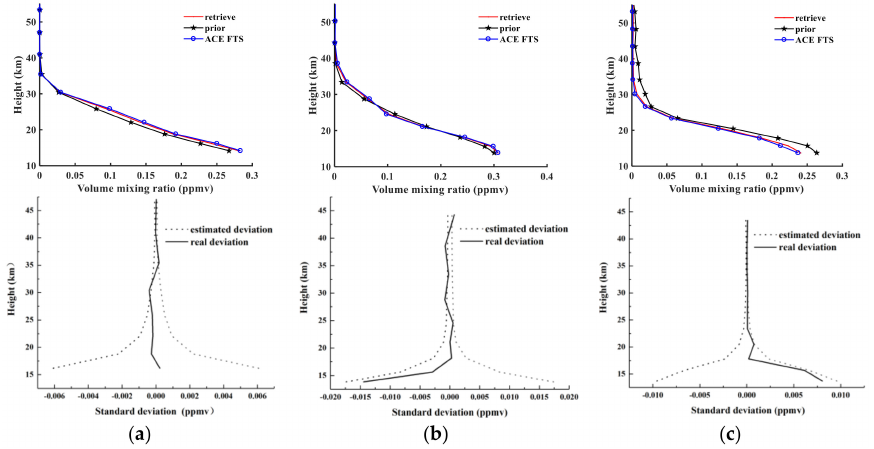
Figure 9. Top panels show N 2 O retrieval results for ( a ) sunrise orbit 40993; ( b ) sunrise orbit 40993; and ( c ) sunrise orbit 48359. Bottom panels show real and estimated absolute deviations for ( a ) sunrise orbit 40993; ( b ) sunrise orbit 40993; and ( c ) sunrise orbit